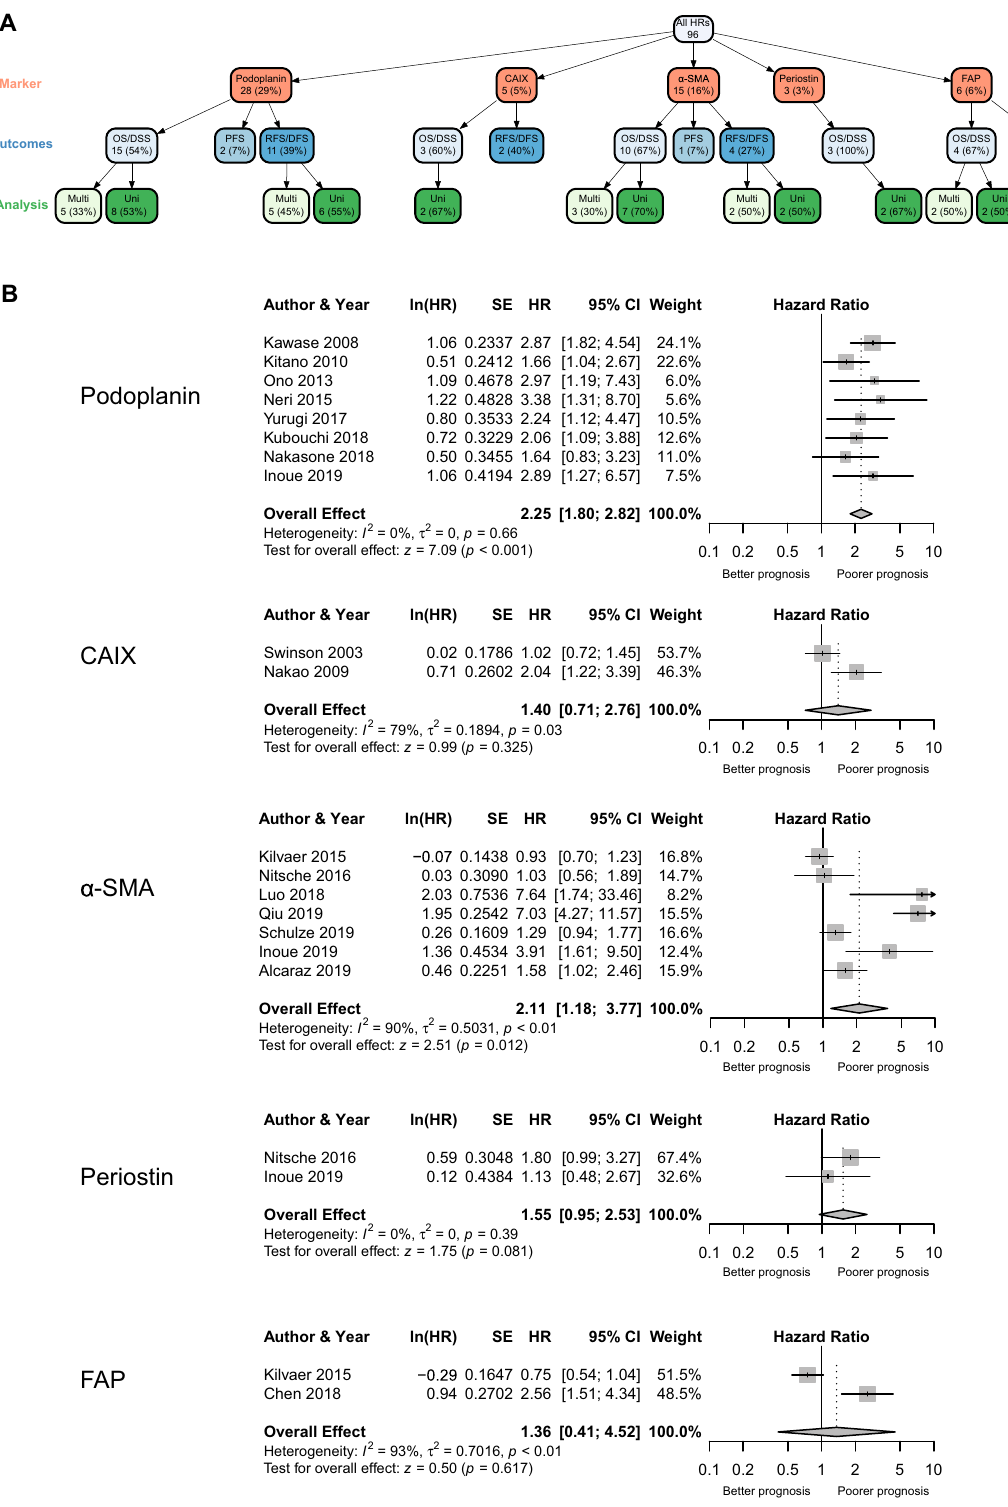
Figure 2. Analysis of individual markers. ( A ) Tree network showing number of studies for each marker per outcome group and analysis method. Figure generated using the vtree package in R (version 3.5.2). ( B ) Random- effect forest plots of individual markers from the OS/DSS outcome group and univariate analysis